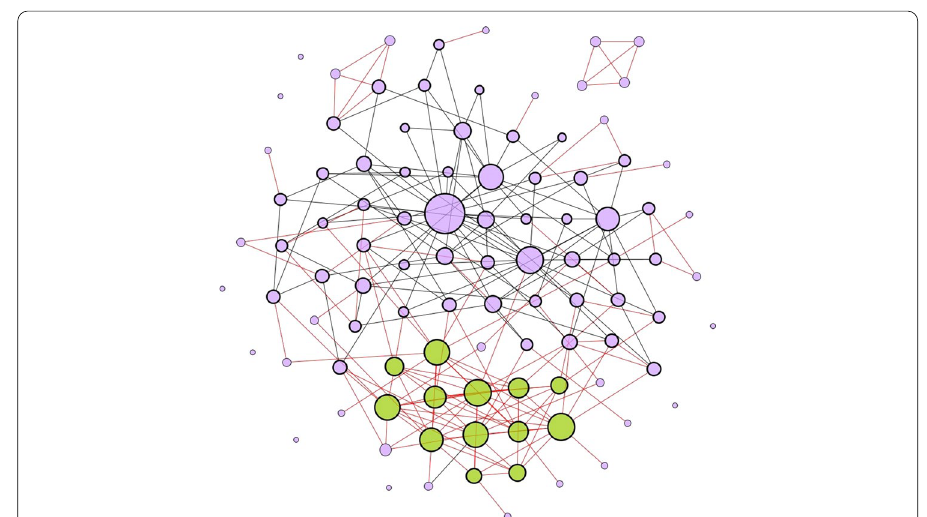
Fig. 1 Illustration of the result of the network generation method on a population of 100 individuals. The edges represent interactions within families, workplaces, and social interaction. The red color edges are the ones that are preserved in the lockdown while the black color edges are deleted. The 4-cliques with red edges, as well as a fraction of 3-cliques with red edges represent families. Node size denotes the degree of the node with isolated nodes having the smallest size; this illustrates that the network contains high-degree hubs. The nodes that have a thick border denote the people who are working. Nodes in green color denote essential workers. The cluster of green nodes shows a high interaction among essential workers